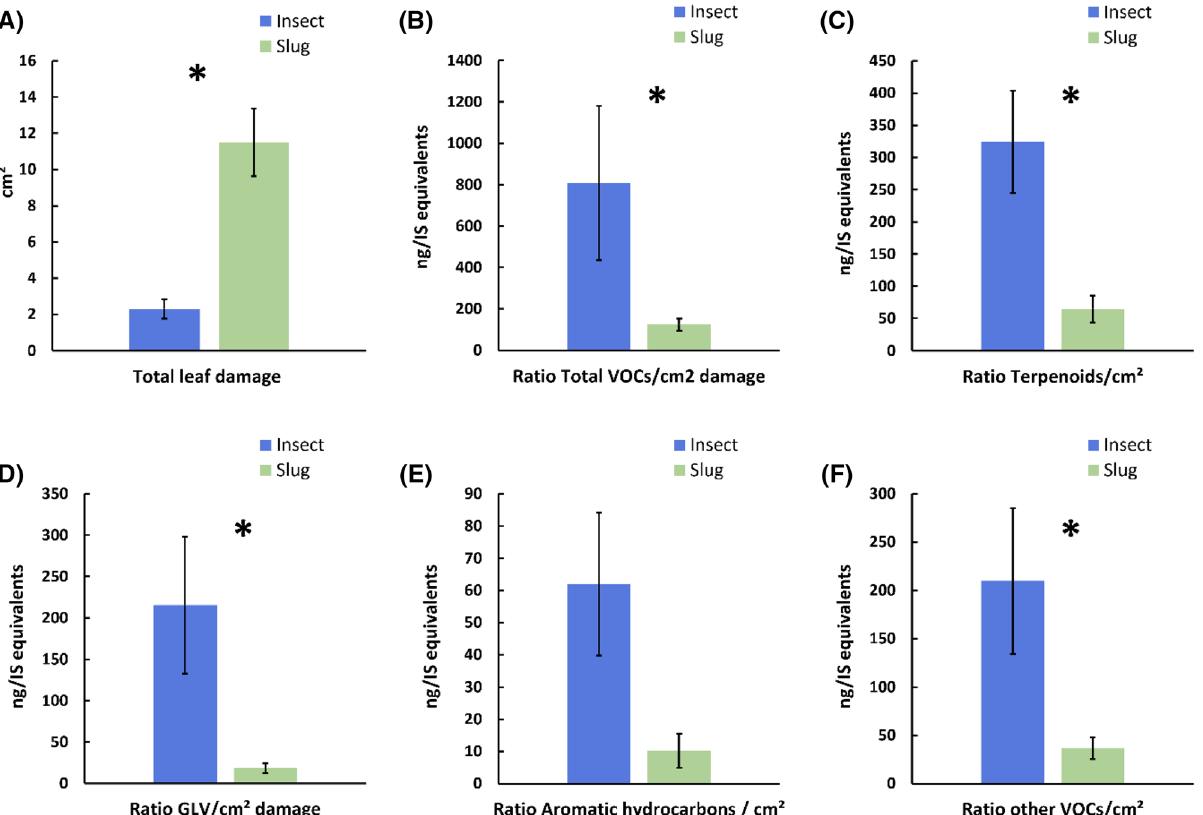
Figure 3. Volatile emissions (ng/IS equivalents) and leaf area consumed (cm 2 ) for all plant species damaged by a caterpillar herbivore ( Spodoptera littoralis ) and a slug herbivore ( Arion vulgaris ) (mean ± SE). ( A ) Total leaf damage (i.e. leaf area eaten); ( B ) Ratio total VOCs emissions/cm 2 of leaf damage; ( C ) Ratio terpenoids/ cm 2 of leaf damage; ( D ) Ratio green leaf volatiles (GLV) emissions/cm 2 of leaf damage; ( E ) Ratio aromatic hydrocarbons/cm 2 ; ( F ) Ratio other VOCs/cm 2 of leaf damage. Means with an asterisk are statistically different (One-way ANOVA, α = 0.05, JMP®